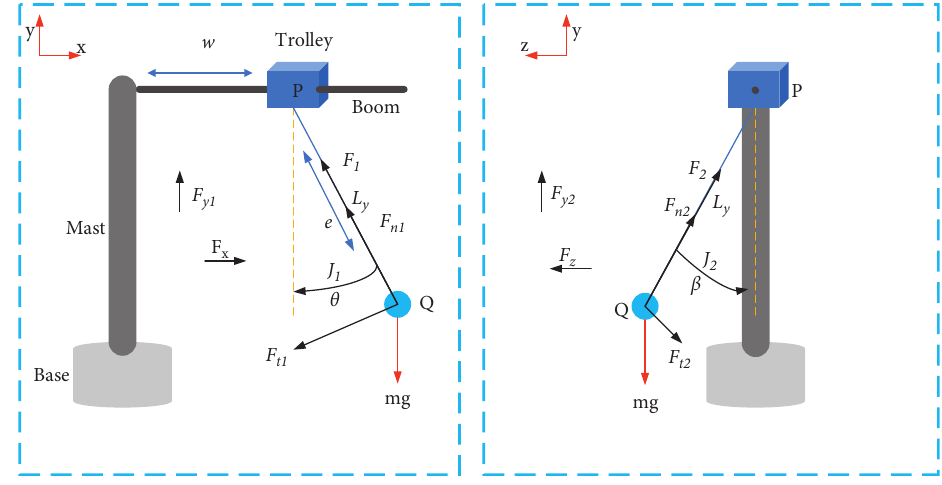
Figure 1: Force analysis of